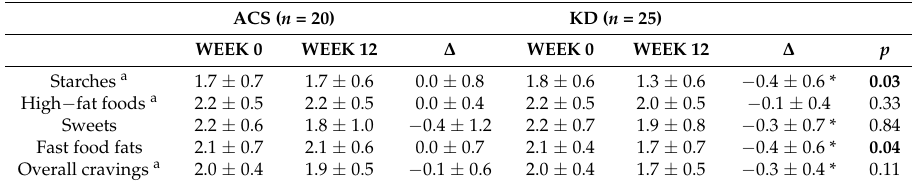
Table 3. Frequency of cravings at baseline and 12-week by